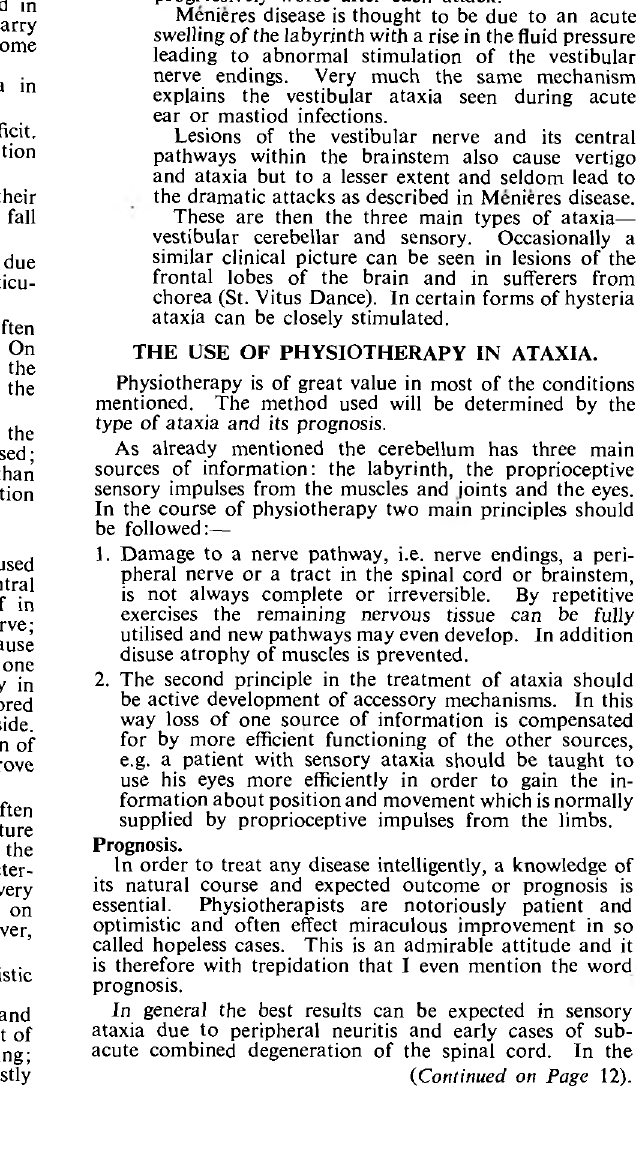
Tabes Dorsalis: a syphilitic inflammation of the sensory spinal roots and dorsal sensory tracks of the spinal cord. The typical clinical case shows severe ataxia with hypotonia of muscles and very poor co-ordination. Once the disease manifests itself it is progressive in spite of medical treatm ent and the ultimate prognosis is therefore poor. Subacute combined degeneration of the cord: this disease is caused by a Vit. B. 12 deficiency and is commonly associated with pernicious anaemia. As in peripheral neuritis the disability is due to both muscular weakness and sensory ataxia. Treatm ent with Vitamin B. 12 always arrests the disease but certainly does not cure it, especially in advanced